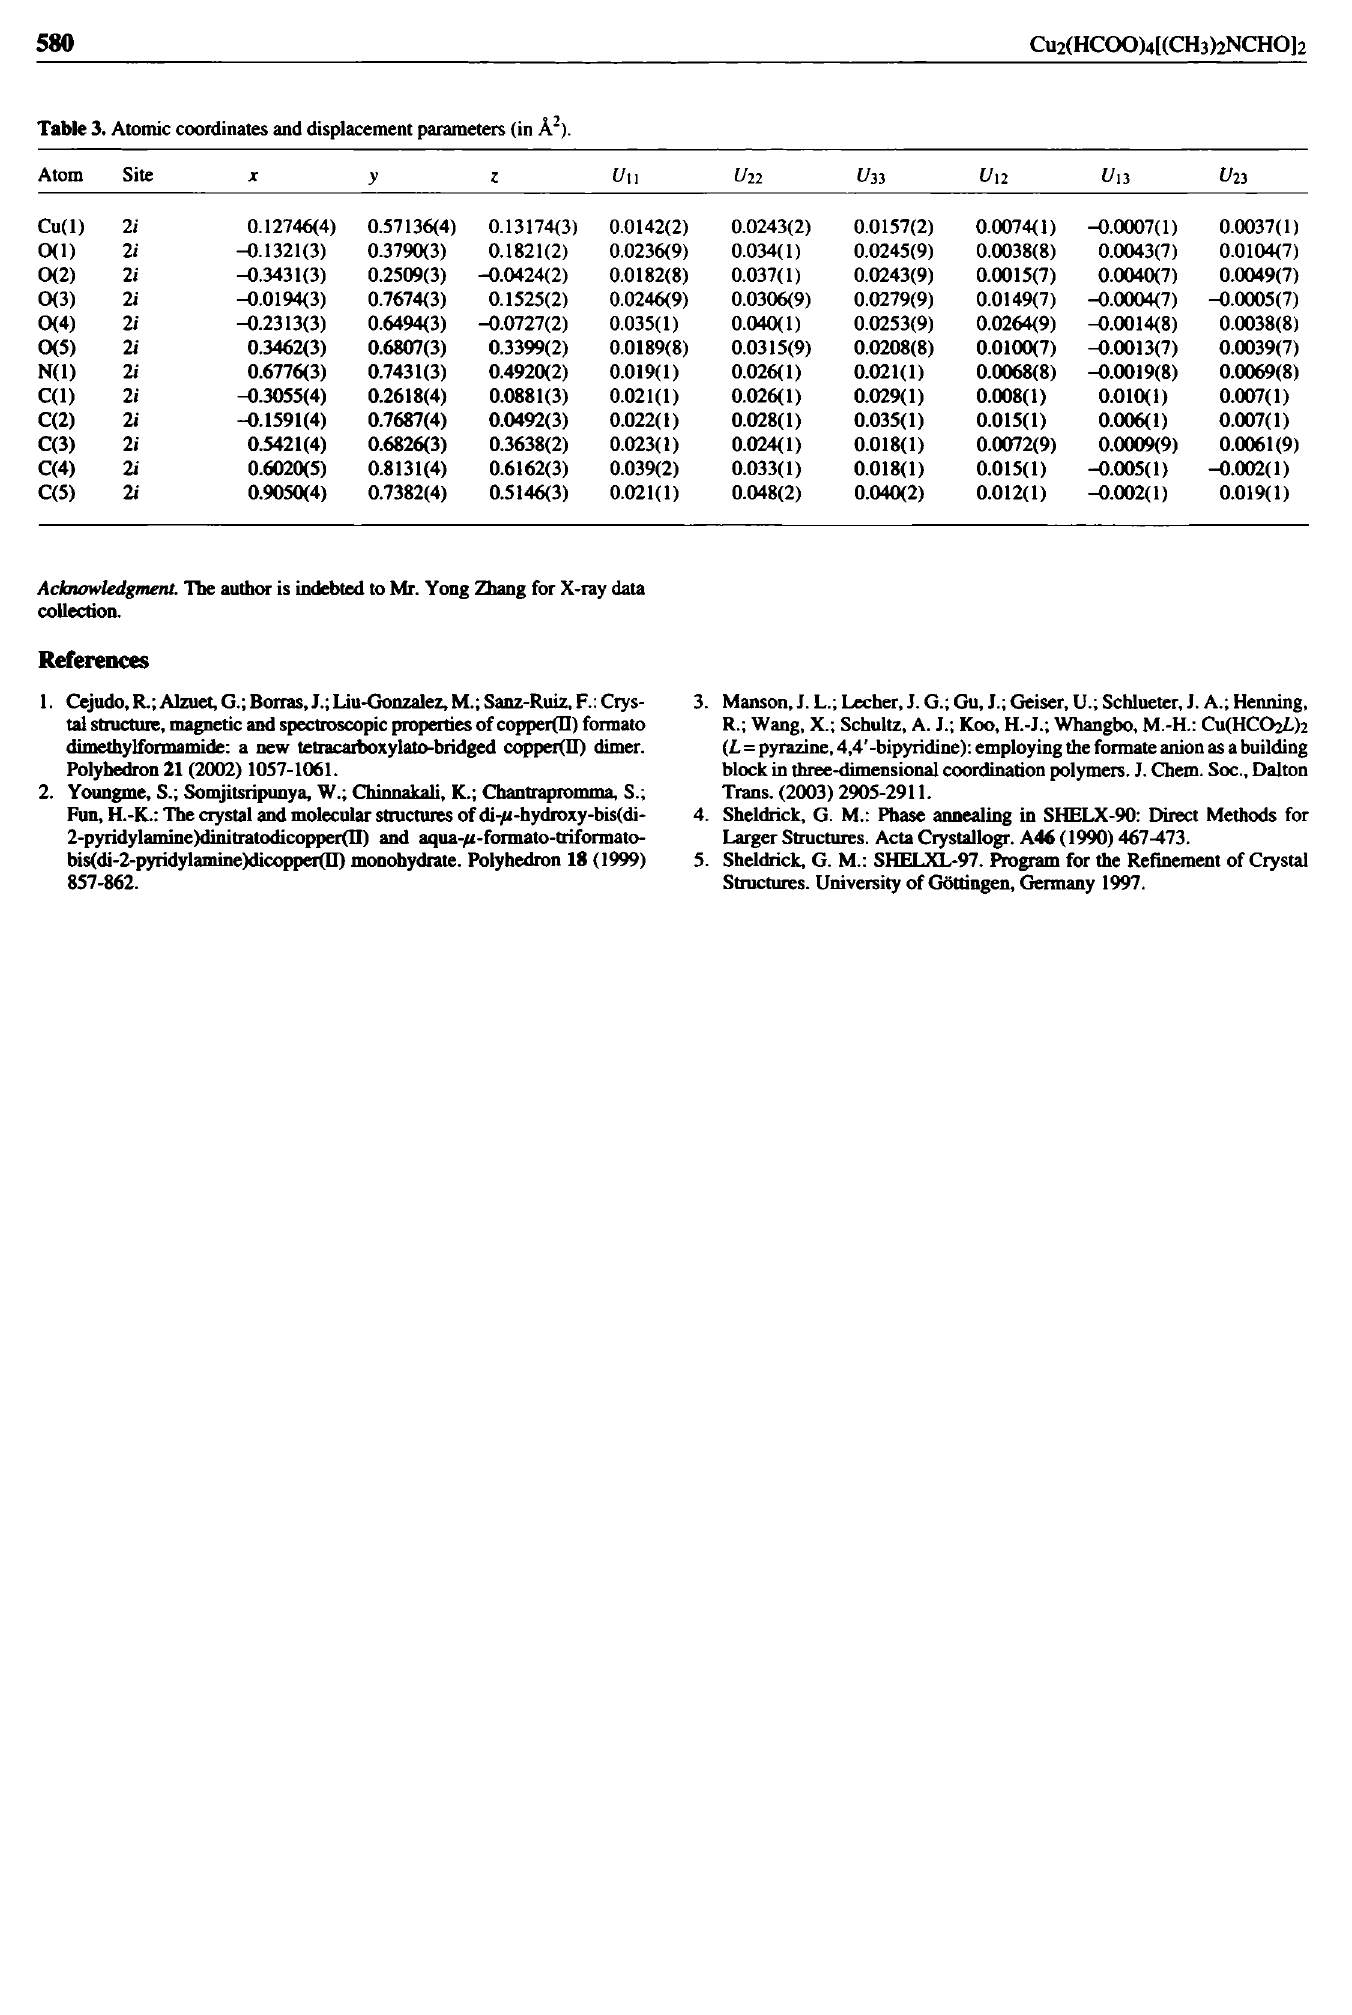
Table 3. Atomic coordinates and displacement parameters (in A 2